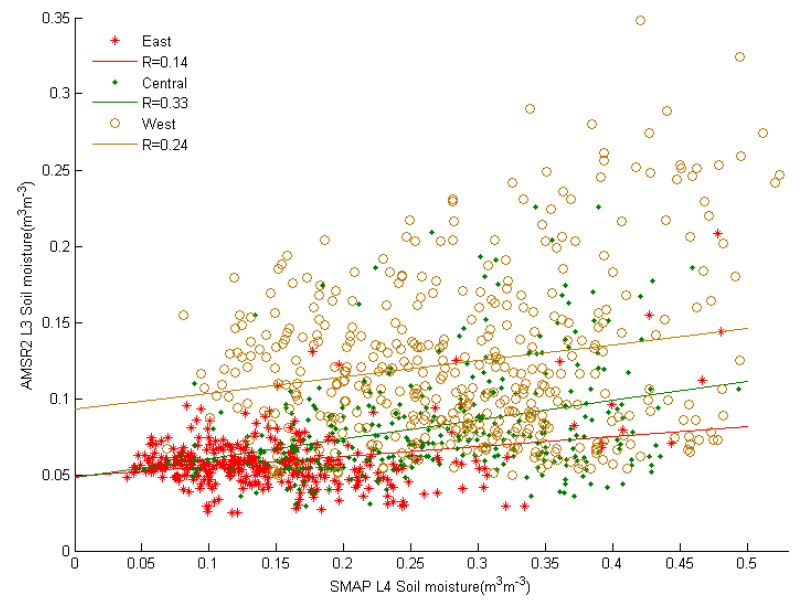
Figure 4. Comparison Soil moisture in different regions between SMAP L4 and AMSR2 L3 data. Remote Sens. 2017 , 9 , 104